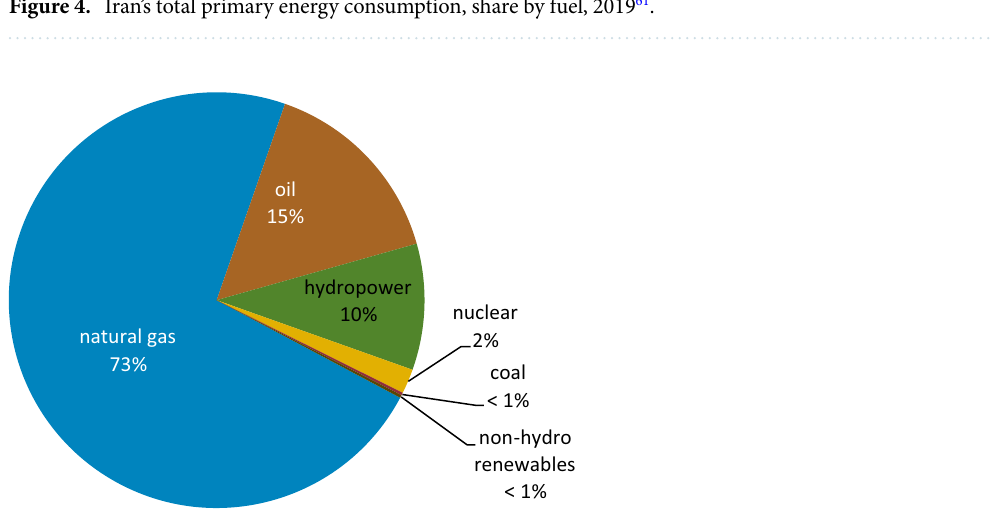
Figure 4. Iran’s total primary energy consumption, share by fuel, 2019 61 .